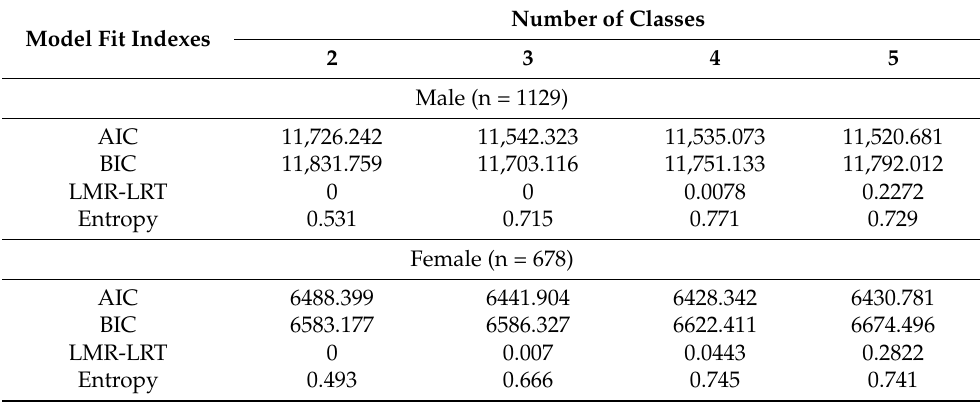
Table 1. Model fit statistics for 2- to 5-class models (n =